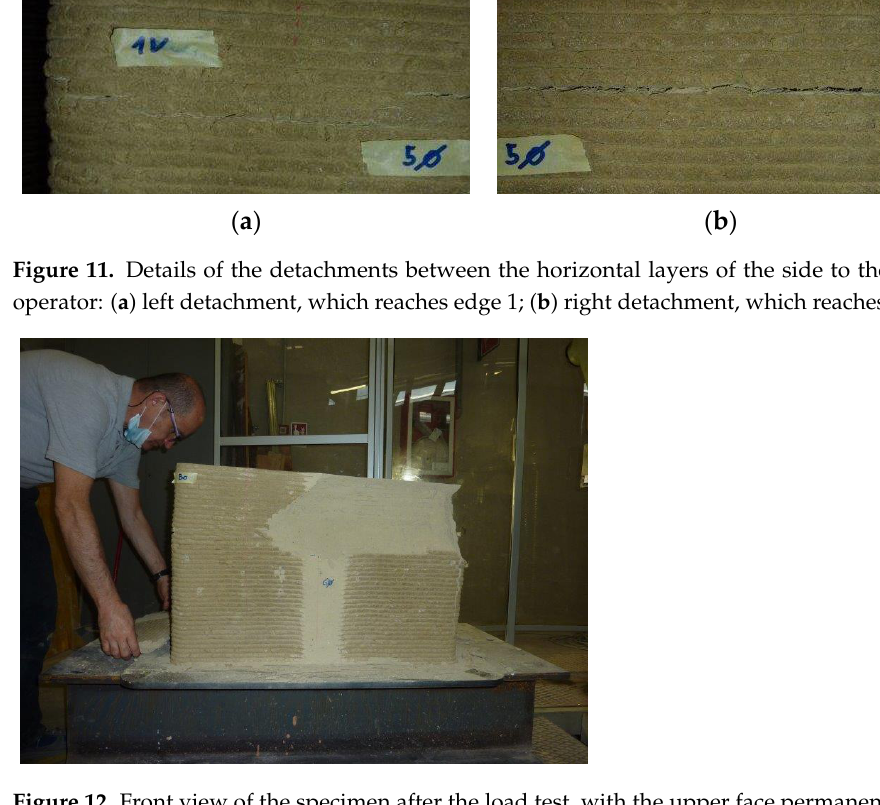
Figure 12. Front view of the specimen after the load test, with the upper face permanently inclined from left to right.